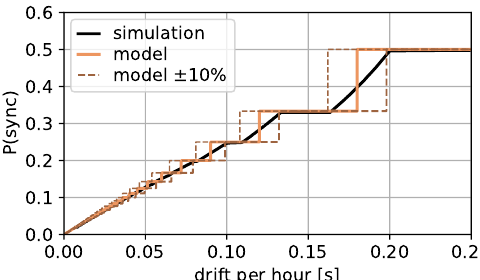
Figure 3. P ( sync ) to clock drift relation.